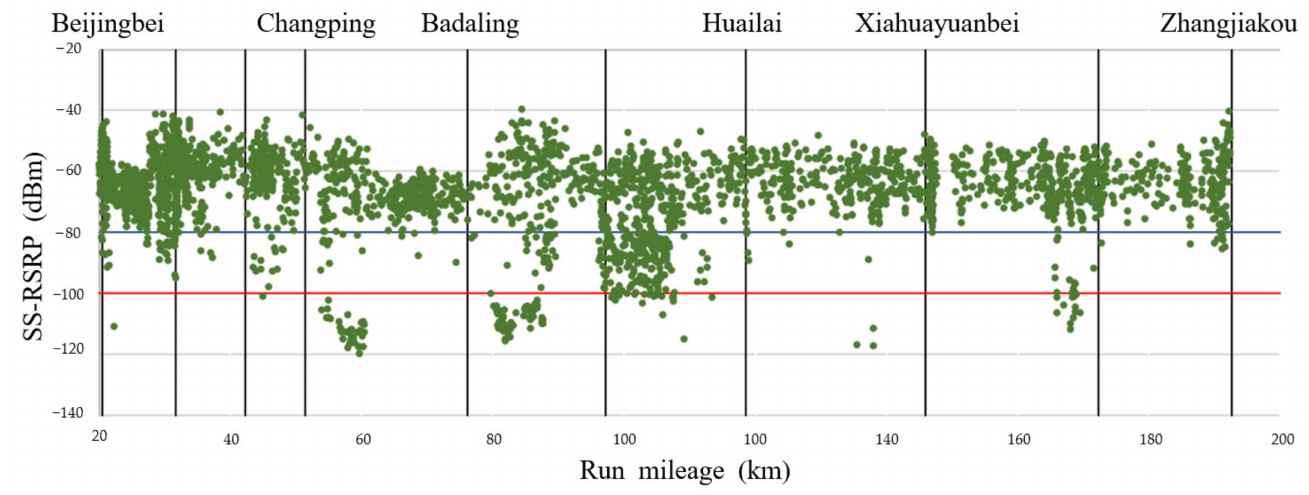
Figure 8. The values of